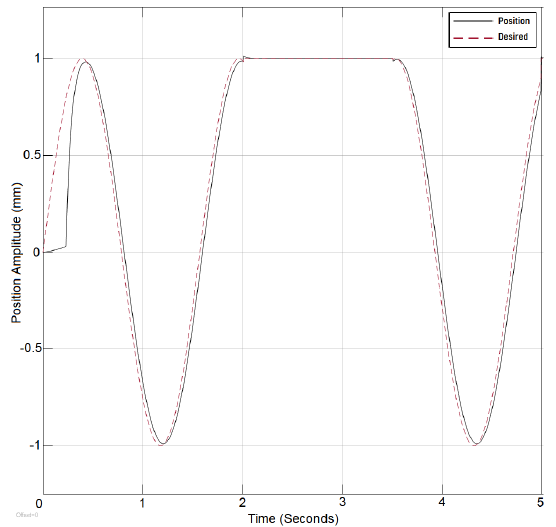
Figure 14. The position with reference to a combination of sinusoidal and step function.